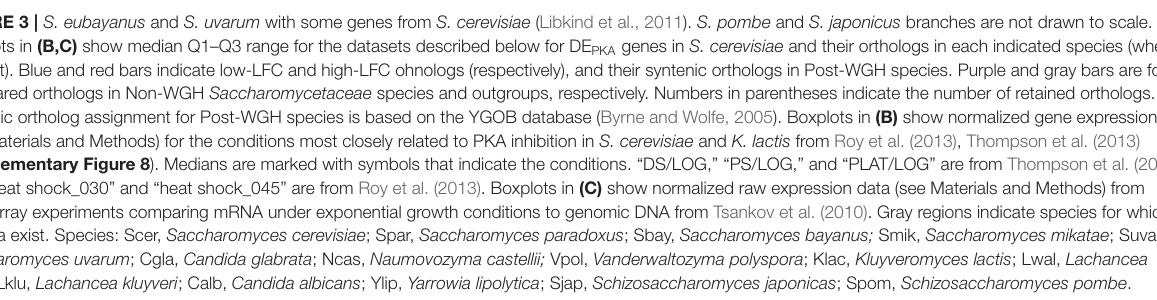
FIGURE 3 | S. eubayanus and S. uvarum with some genes from S. cerevisiae (Libkind et al., 2011). S. pombe and S. japonicus branches are not drawn to scale. Boxplots in (B,C) show median Q1–Q3 range for the datasets described below for DE PKA genes in S. cerevisiae and their orthologs in each indicated species (when present). Blue and red bars indicate low-LFC and high-LFC ohnologs (respectively), and their syntenic orthologs in Post-WGH species. Purple and gray bars are for the shared orthologs in Non-WGH Saccharomycetaceae species and outgroups, respectively. Numbers in parentheses indicate the number of retained orthologs. Syntenic ortholog assignment for Post-WGH species is based on the YGOB database (Byrne and Wolfe, 2005). Boxplots in (B) show normalized gene expression (see Materials and Methods) for the conditions most closely related to PKA inhibition in S. cerevisiae and K. lactis from Roy et al. (2013), Thompson et al. (2013) ( Supplementary Figure 8 ). Medians are marked with symbols that indicate the conditions. “DS/LOG,” “PS/LOG,” and “PLAT/LOG” are from Thompson et al. (2013) and “heat shock_030” and “heat shock_045” are from Roy et al. (2013). Boxplots in (C) show normalized raw expression data (see Materials and Methods) from microarray experiments comparing mRNA under exponential growth conditions to genomic DNA from Tsankov et al. (2010). Gray regions indicate species for which no data exist. Species: Scer, Saccharomyces cerevisiae ; Spar, Saccharomyces paradoxus ; Sbay, Saccharomyces bayanus; Smik, Saccharomyces mikatae ; Suva, Saccharomyces uvarum ; Cgla, Candida glabrata ; Ncas, Naumovozyma castellii; Vpol, Vanderwaltozyma polyspora ; Klac, Kluyveromyces lactis ; Lwal, Lachancea waltii ; Lklu, Lachancea kluyveri ; Calb, Candida albicans ; Ylip, Yarrowia lipolytica ; Sjap, Schizosaccharomyces japonicas ; Spom, Schizosaccharomyces pombe